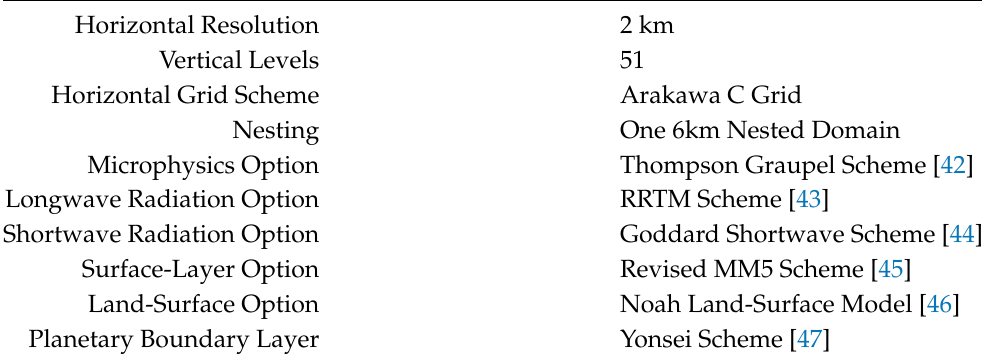
Table 2. Details of the WRF simulation